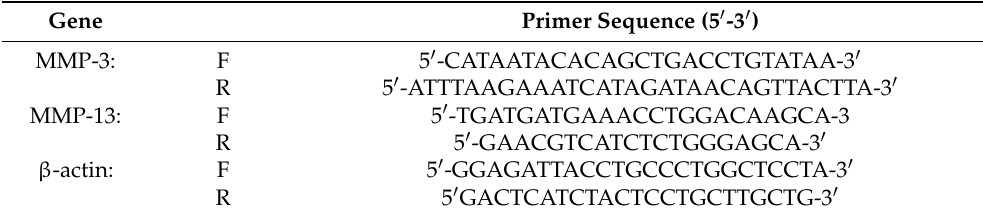
Table 1. The primer pair sequences of β -actin, MMP-3, and MMP-13 genes.